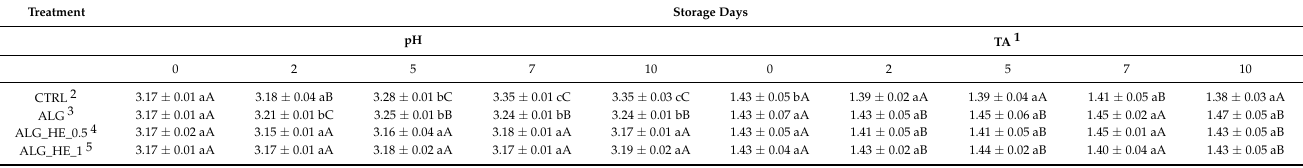
Table 2. Effects of analyzed edible coatings on pH and titratable acidity of fresh-cut kiwifruit (mean ± sd; n = 5). Treatment